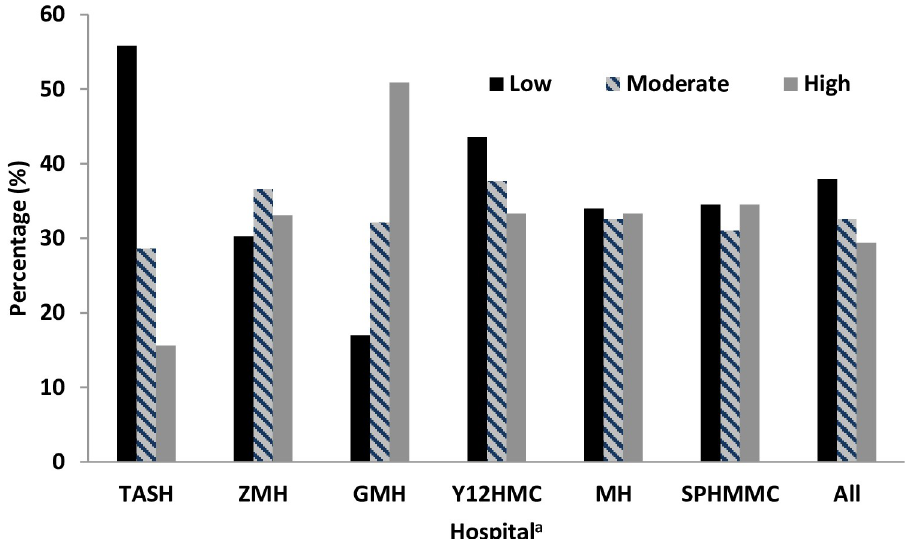
Fig 1. Pattern of worry scores of COVID-19 crisis by hospital. a TASH: Tikur Anbessa Specialized Hospital; ZMH: Zewditu Memorial Hospital; GMH: Ghandi Memorial Hospital; Y12HMC: Yekatit 12 Hospital Medical College; MH: Menelik II Hospital; SPHMMC: St. Paul Hospital Millennium Medical College.